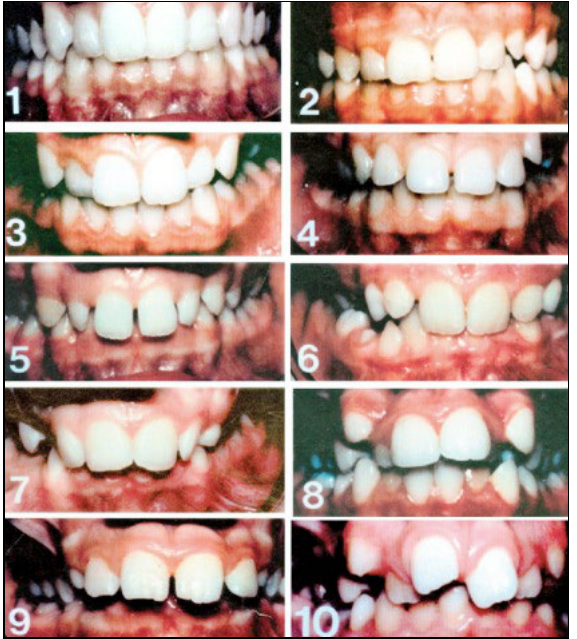
Figure 1. IOTN Aesthetic Components. ([Copyright statement: ‘The SCAN scale was first published in 1987 by the European Orthodontic Society (Evans R, Shaw W. Preliminary evaluation of an illustrated scale for rating dental attractiveness. Eur J Orthod 1987;9:314-8]’).